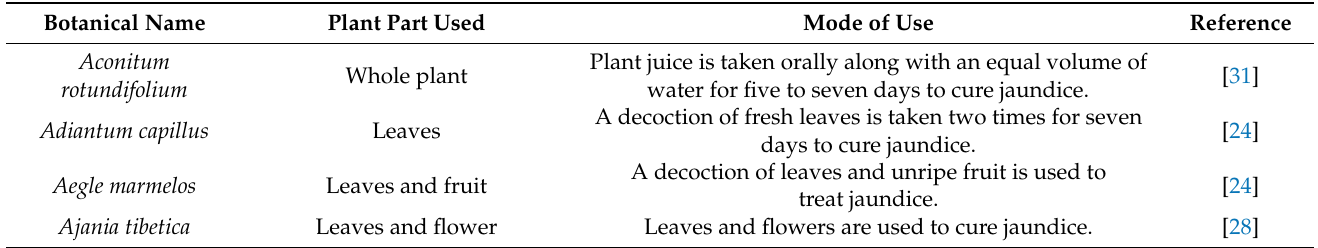
Table 2. Mode of use of ethnomedicinal plants for treating